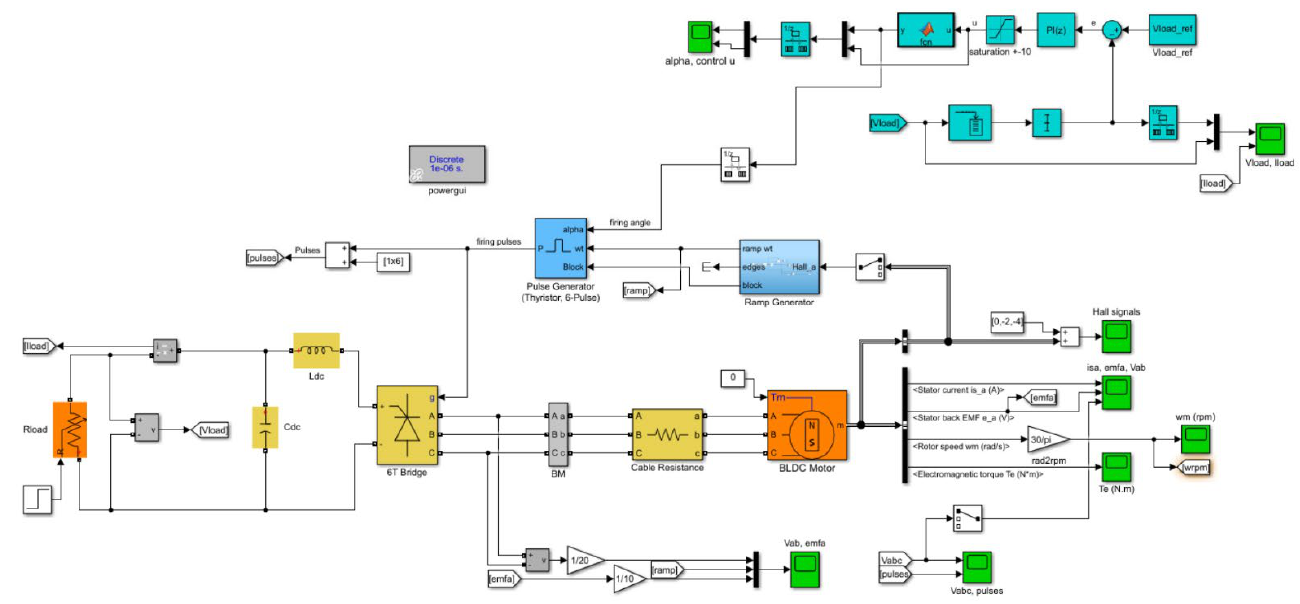
Figure 5. Simulink model of the flywheel energy storage energy recovery subsystem with BLDC motor, 6T thyristor rectifier and the load voltage control system.